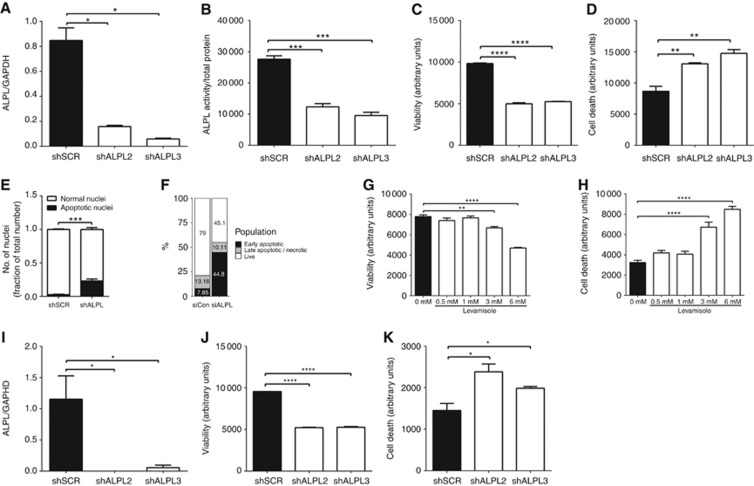
Inhibition of alkaline phosphatase activity decreases cell viability and increases apoptosis. Knockdown of alkaline phosphatase was confirmed in ARCaPM cells transduced with scrambled shRNA (shSCR) or ALPL-knockdown shRNA (shALPL2 and shALPL3) by measuring (A) ALPL mRNA using qRT–PCR and (B) alkaline phosphatase activity (normalised with total protein) using a quantitative fluorimetric assay, 72 h after transduction. (C) Viability of the transduced cells was measured using Alamar Blue assay and (D) cell death was measured using YO-PRO-1. (E) Apoptotic nuclei, identified from their fragmented appearance, were counted in ImageJ (imagej.nih.gov). (F) Apoptosis was quantitated using annexin V/PI staining. Viability (G) and (H) cell death were also measured in ARCaPM cells treated with increasing concentrations of levamisole using Alamar Blue assay and YO-PRO-1 staining, respectively. (I) ALPL knockdown in PC3 cells was confirmed using qRT–PCR and (J) the effects of viability were measured using Alamar Blue assay and (K) cell death was measured using YO-PRO-1 staining. (*P<0.05, **P<0.01, ***P<0.001, ****P<0.0001).